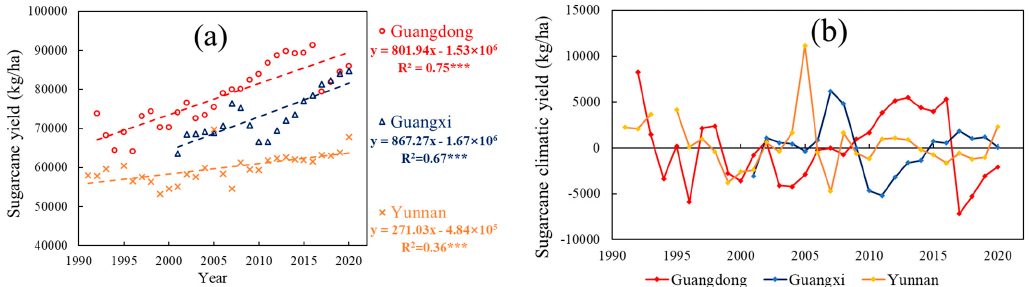
Figure 9. The actual yield ( a ) and climatic yield ( b ) of sugarcane in Guangdong, Guangxi, and Yunnan provinces. *** indicates p < 0.001.